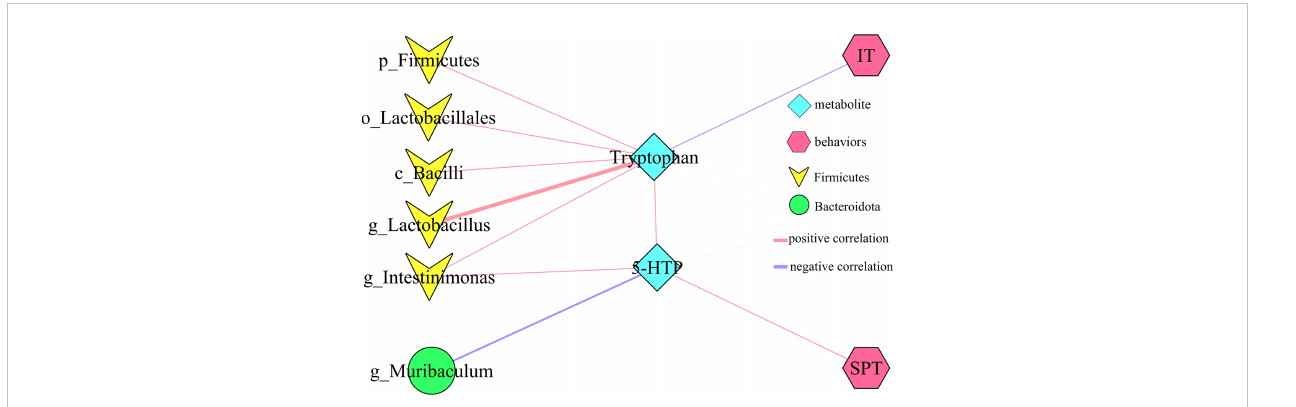
FIGURE 6 Correlations between differential bacterial taxa, 5-HTP, Tryptophan and depressive-like behaviors. SPT, sucrose preference; IT, immobility time; 5- HTP, 5-hydroxytryptophan.